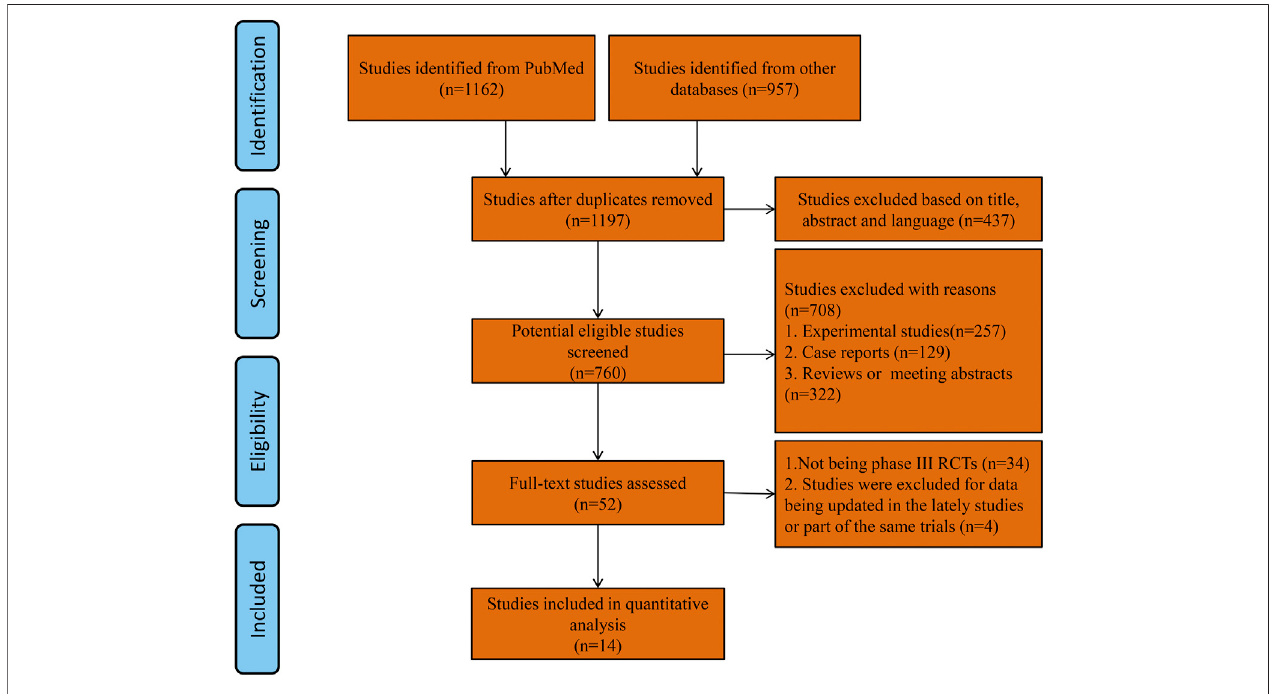
FIGURE 1 | Flow diagram of trial selection.